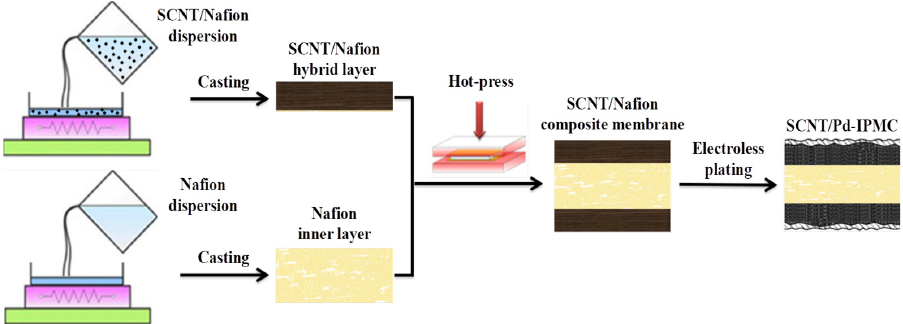
Figure 2. Schematic illustration of fabrication process of SCNT/Pd ‐ IPMC.